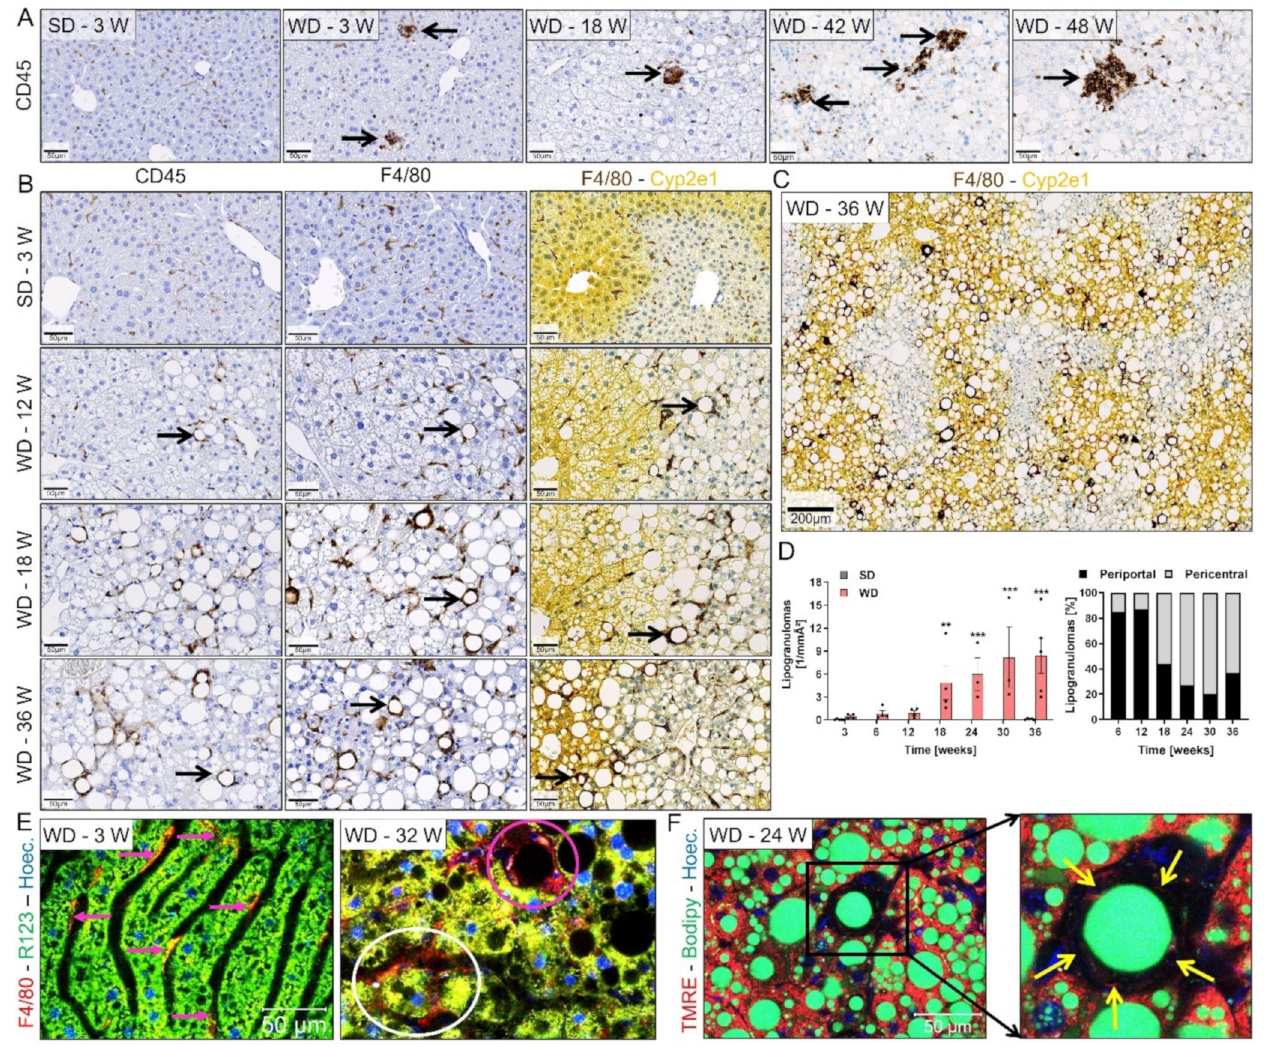
Figure 3. Formation of lipogranulomas (‘macrophage crowns’) after Western diet feeding. ( A ) Visualization of inflammatory foci by CD45 immunostaining. ( B ) Visualization of lipogranulomas (arrows) by immunostaining of CD45 and F4/80, and their lobular zonation by co-staining with the pericentral marker Cyp2e1; an overview image of WD week 36 is shown in ( C ). ( D ) Quantification of lipogranulomas’ density and zonation on whole slide scans in relation to the lobular zone; data represent the mean and standard error of 3–7 mice per time point. **: p < 0.01; ***: p < 0.001 compared to SD week 3. Unpaired t test; data of individual mice are illustrated by dots; SD: standard diet; WD: Western diet. ( E ) Intravital imaging of livers of WD-fed mice after intravenous injection of a fluorophore-coupled F4/80 antibody (red), the mitochondrial membrane potential marker Rhodamine123 (R123), and Hoechst for nuclear staining. The red arrows indicate Kupffer cells, the white circle shows a vital steatotic hepatocyte with mitochondrial and nuclear structures surrounded by F4/80 positive macrophages, and the pink circle indicates a lipid droplet enclosed by macrophages without discernible mitochondria or nuclear signal. ( F ) Intravital imaging of lipid droplets visualized by Bodipy; the yellow arrows indicate macrophages surrounding a lipid droplet. (See also Videos S3 and S4). Scale bars: 50 µ m ( A , B , E , F ) and 200 µ m ( C